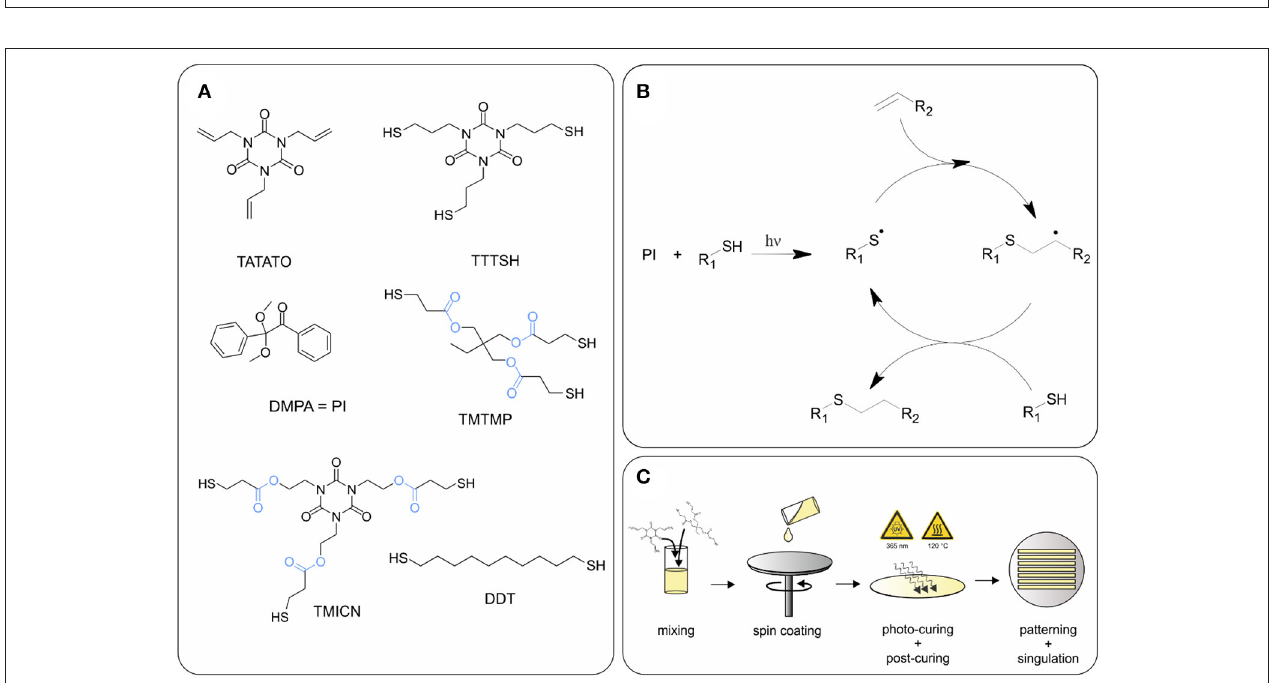
FIGURE 1 | (A) Chemical structures of monomers and photoinitiator (PI) used for synthesis of polymers SMP-A and SMP-B. Ester groups are highlighted in blue, (B) reaction mechanism of thiol-ene click reaction, and (C) schematic of polymer fabrication. samples were then placed in a vacuum oven at 120 ◦ C and 5 inHg ( ∼ 16.9 kPa) for 24 h to further complete network